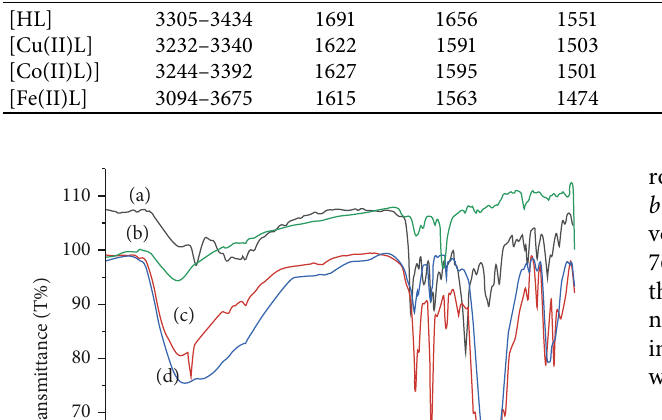
Figure 2: UV-vis absorption spectra of the azo dye ligand (HL) and its Cu (II), Co(II), and Fe(II) metal complexes in DMSO. Table 2: Important FT-IR spectral bands (cm − 1 ) of the HL ligand and its complexes. Compound